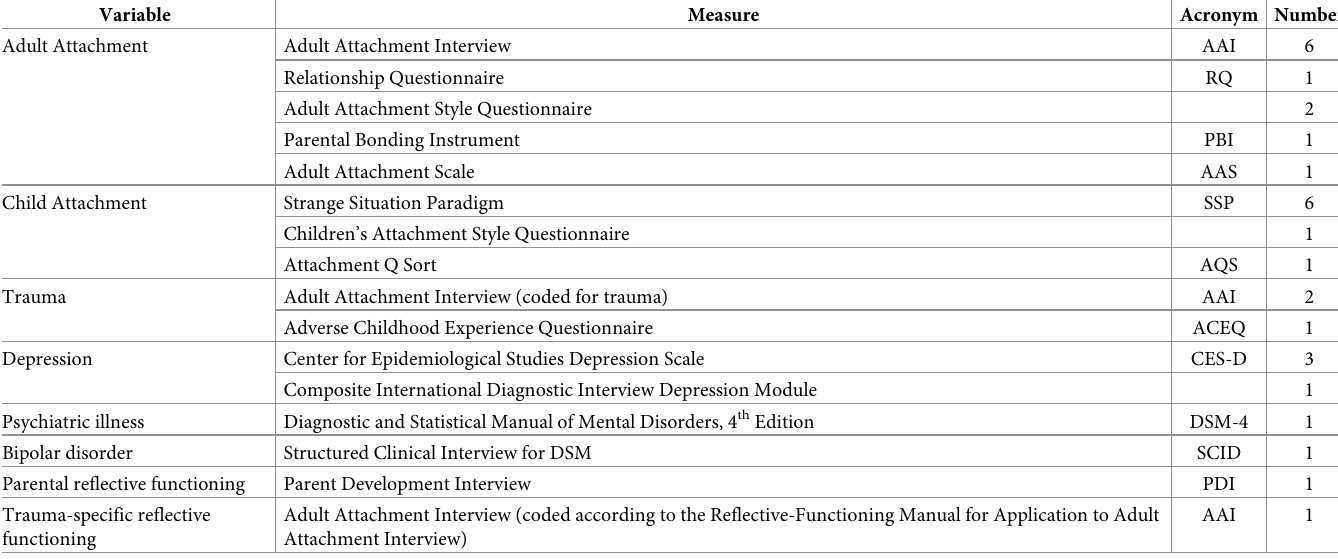
Table 3. Screening tools and measures of the included studies.